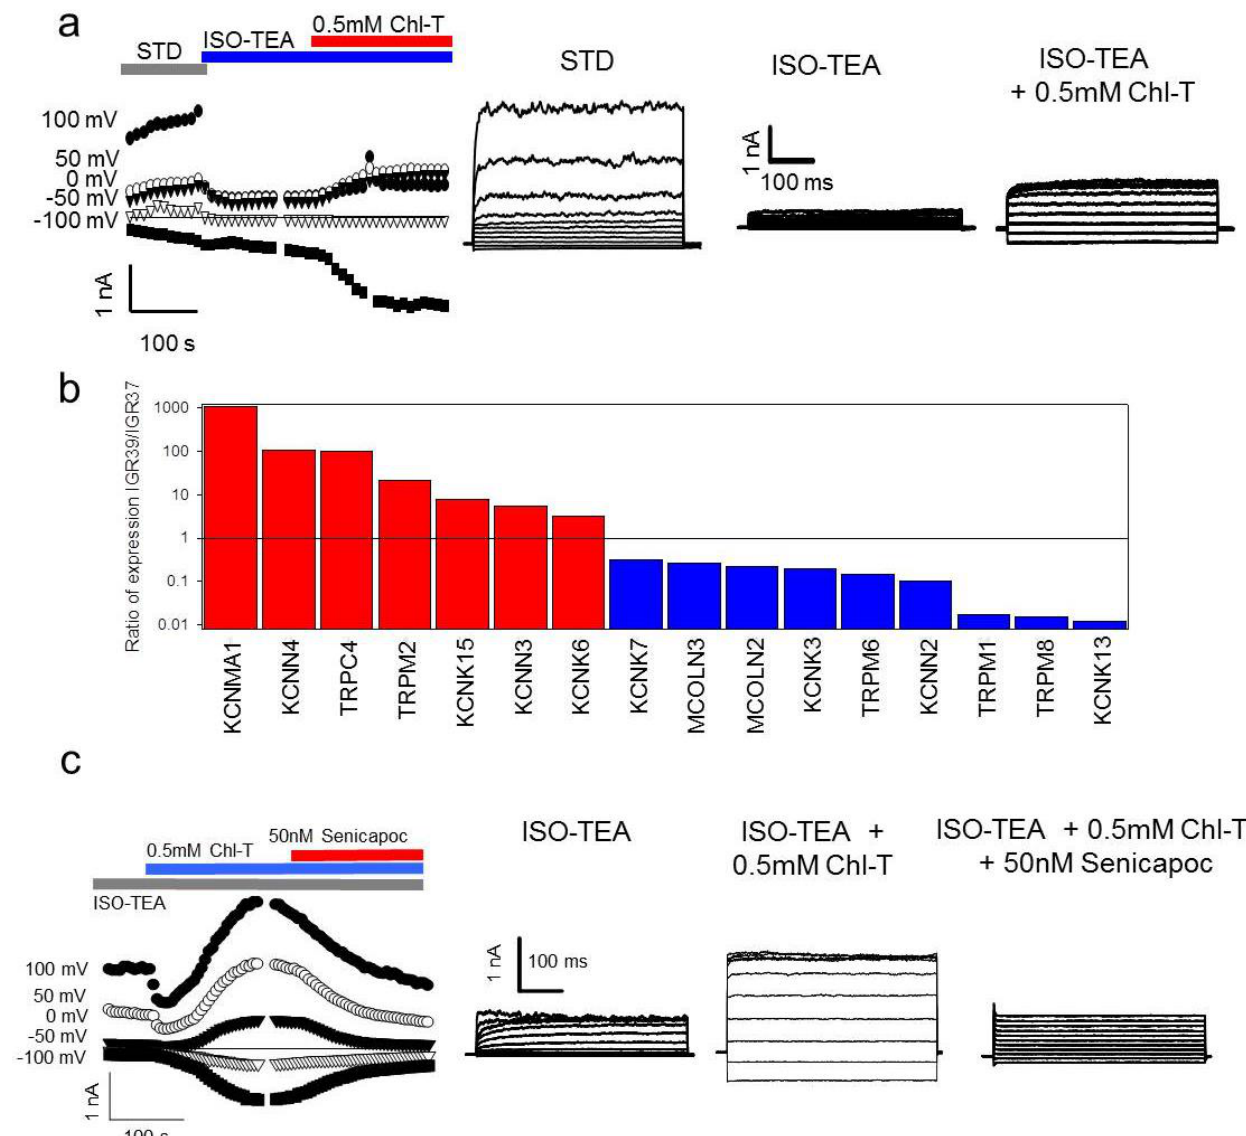
Figure 4. ( a ) Activation of TEA-insensitive current component by Chl-T. Right: time course of currents elicited in a representative IGR39 cell. Application of the ISO-TEA solution (blue bar) inhibited constitutively active BK-mediated currents. Subsequent addition of 0.5 mM Chl-T activated a significant current component. Left: IV relationships in the indicated conditions. ( b ) Comparative gene expression analysis of K + and TRP ion channel genes in IGR39 vs. IGR37 cells. As expected, KCNMA1 was highly expressed in IGR39 compared to IGR37 cells. Among other Ca 2+ -activated K + channels, KCNN4 -encoded KCa3.1 is more expressed in IGR39 cells, and among TRP channels, TRPC4 and TRPM2 are significantly more expressed in IGR39 cells. The analysis is based on the GSE137391 dataset, as described in the Materials and Methods section. The plot shows only genes with fold change > 2 (see also Table S2). The TRPA1 channel that has been reported to be activated by 0.1 mM Chl-T [64] is weakly expressed in both cell lines, and 1.6-fold more in IGR37 compared to IGR39 cells. ( c ) Inhibition of the TEA-insensitive component by senicapoc. Right: time course of currents elicited in a representative IGR39 cell kept initially in ISO-TEA, and then exposed to 0.5 mM Chl-T in ISO-TEA. Addition of 50 nM senicapoc—a specific inhibitor of KCa3.1—led to an immediate block of the TEA-insensitive potassium current. Left: IV relationships in the indicated